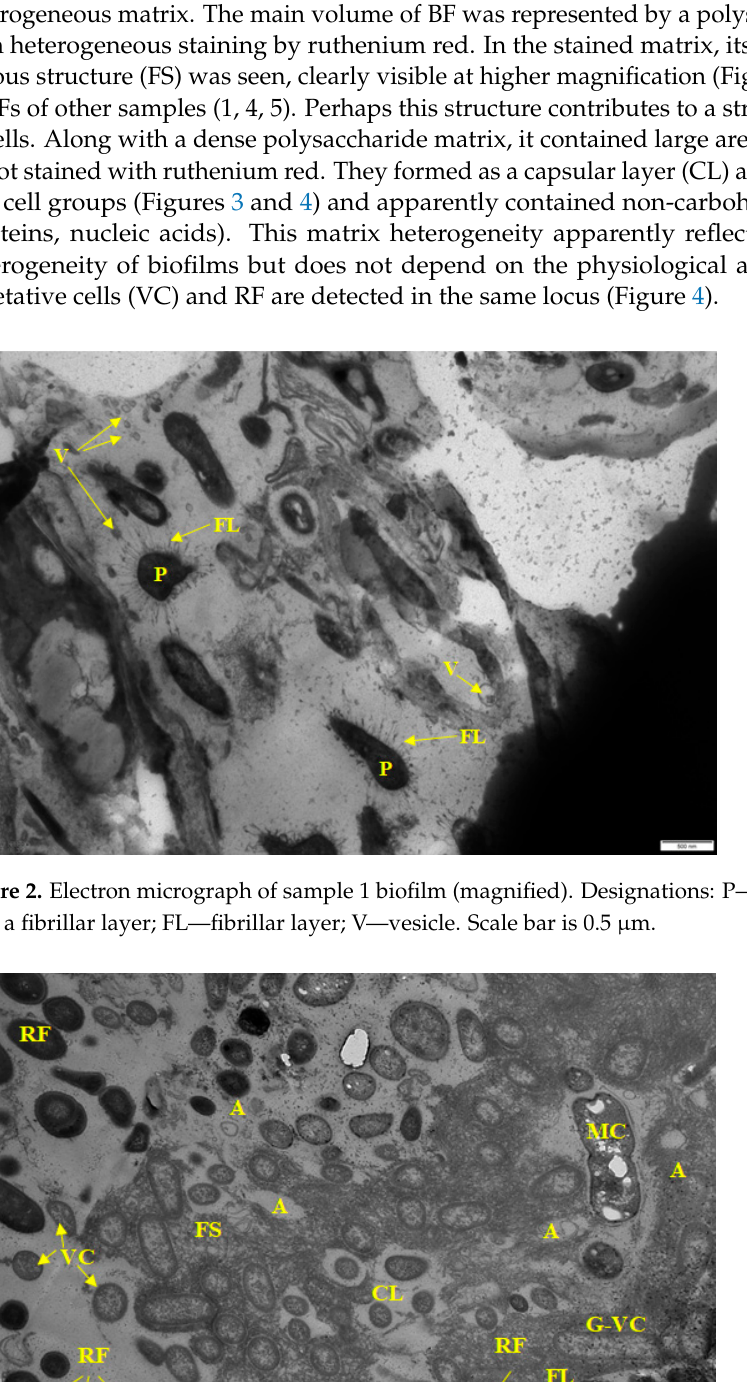
Figure 4. Electron micrograph of sample 2 biofilm (magnified). Designations: VC—vegetative cells; RF—resting forms; CL—capsular layer; A—autolyzed cell: CN—compacted nucleoid. Scale bar is 0.5 µm. The pronounced age heterogeneity of the cells in biofilm consortium was found, with various cell types simultaneously present in the microzone(s): vegetative cells; resting forms characterized by a thickened cell wall, electron-dense cytoplasm (compared to veg- etative cells), and compacted nucleoid (CN); as well as autolyzed cells (A) with only re- sidual cell membrane. Sample 4 was a multispecies biofilm with 5 types of morphologically different cells, many of which were similar to cells from samples 1 and 2 (Figure 5). On the sections, vegetative and resting cells are well identified; as well as cells with multiple inclusions, apparently of polyoxybutyric acid (POBA), which accumulates in stationary and resting cells.